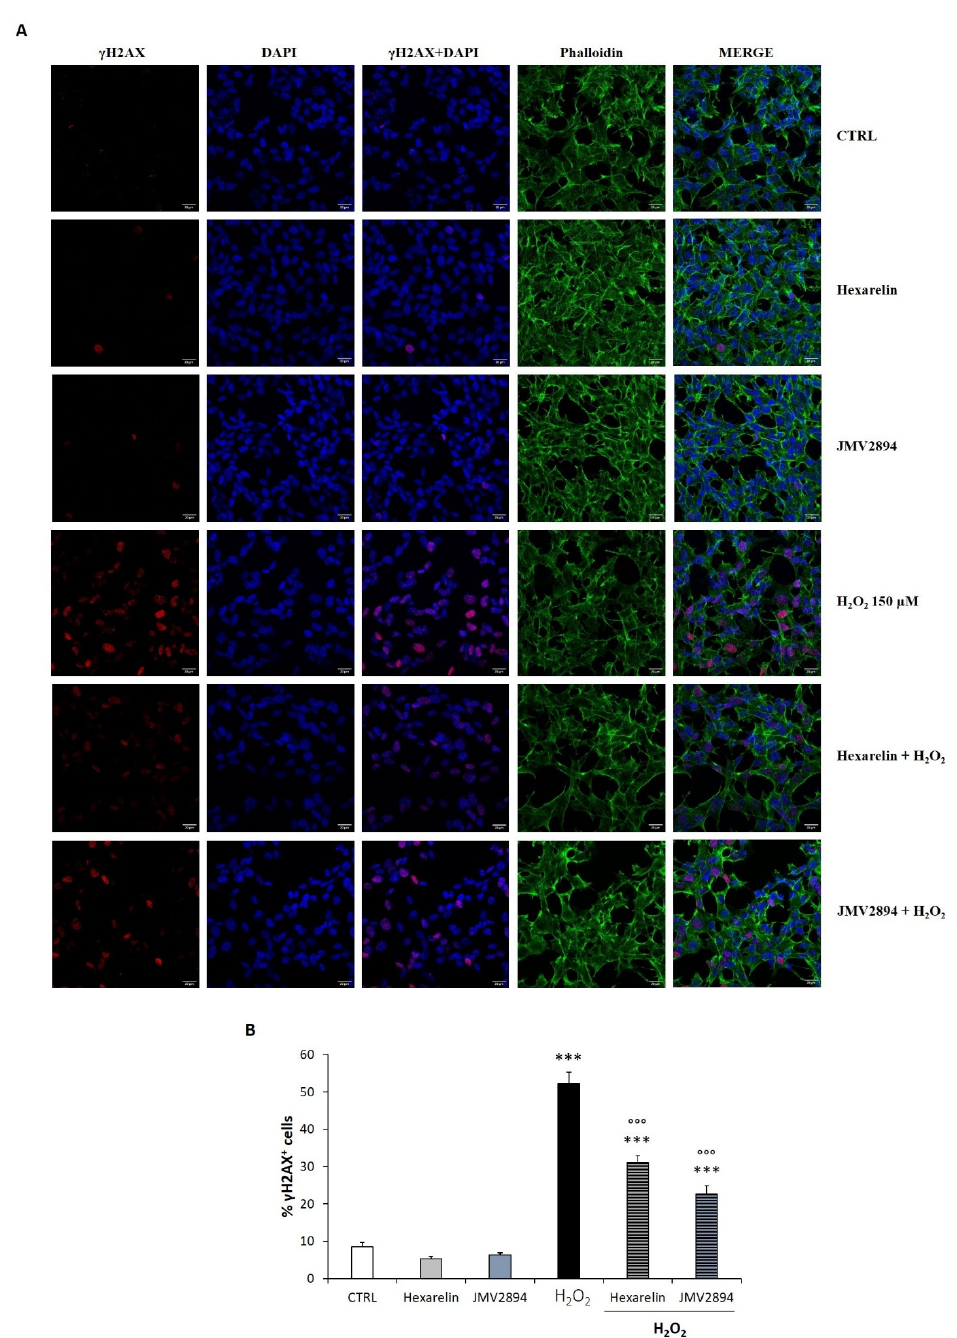
Figure 11. GHS modulated γ H2AX foci accumulation in the nucleus induced by H 2 O 2 . ( A ) The SH- SY5Y SOD1 G93A cells were seeded on poly-D-lysine pre-treated coverslips and incubated for 24 h with or without GHS and 150 µ M H 2 O 2 . At the end of the treatment, cells were fixed, incubated with anti- γ H2AX antibody and stained for phalloidin and DAPI. Images were captured with a confocal laser scan microscope. Scale bar: 20 µ m. ( B ) Graphical representation of the γ H2AX nuclear